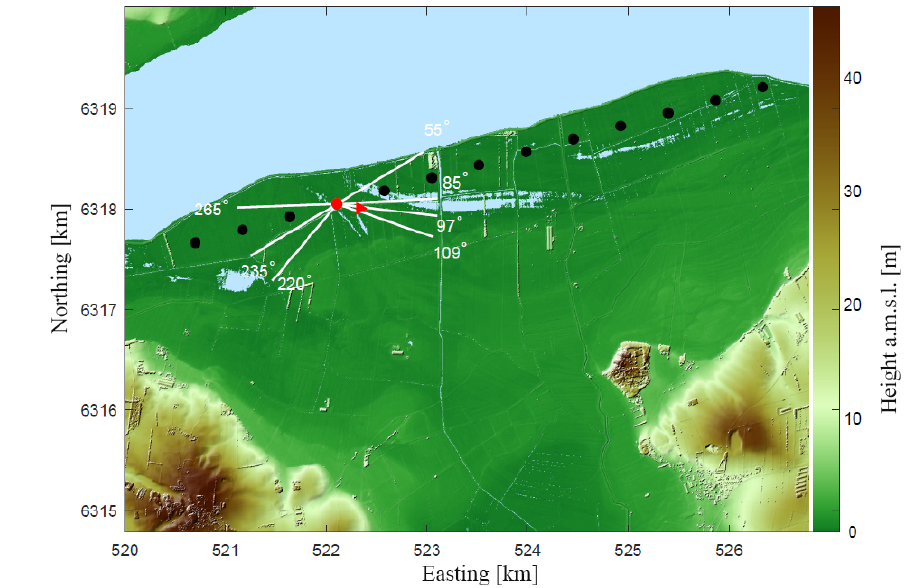
Figure 1. The Nørrekær Enge wind farm in northern Denmark on a digital surface elevation model (UTM32 WGS84). The wind turbines are shown in circles, the turbine T04 with the nacelle lidars in red, and the mast as a triangle. The sectors used for the analysis are also shown; narrow direction sector: 97–109 ◦ ; wide direction sector: 97–220 ◦ ; wake sectors: 55–85 and 235–265 ◦ . The waters of Limfjorden are shown in light blue.